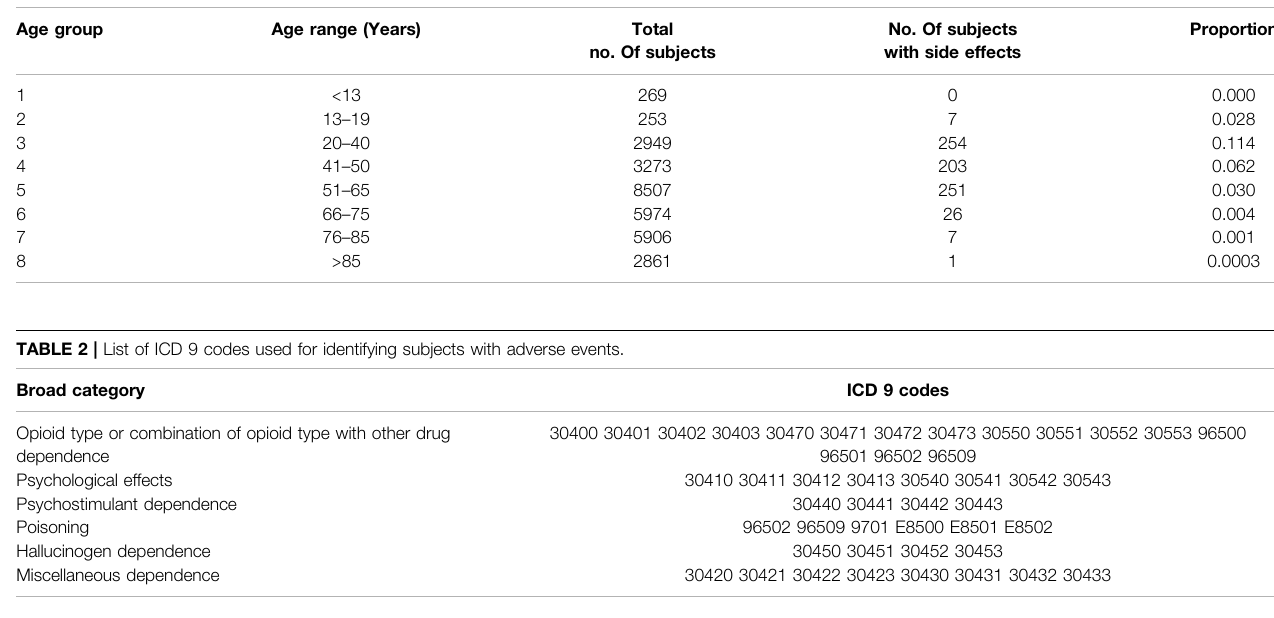
TABLE 1 | Statistics of subjects in different age groups. Age group